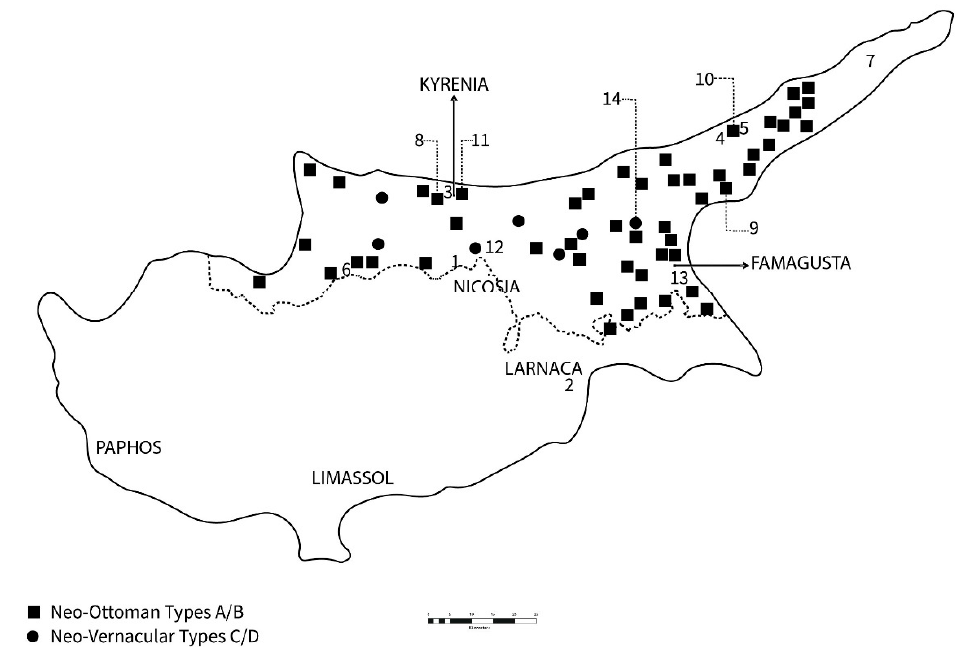
Figure 1. Cyprus. Location of the mosques discussed in detail in the text (1–14), and of the neo- Ottoman and neo-vernacular, types A–D (map: authors and Mojtaba Karimnezhad). 1: Arab Ahmet Pa¸sa mosque (Ottoman); 2: Hala Sultan Tekke mosque (Ottoman); 3: A˘ga Cafer Pa¸sa